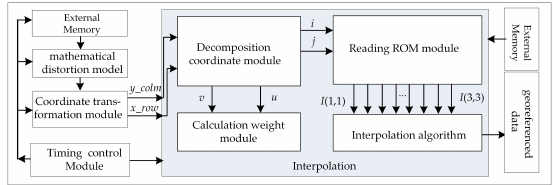
Figure 1. The architecture of georeferencing for RS